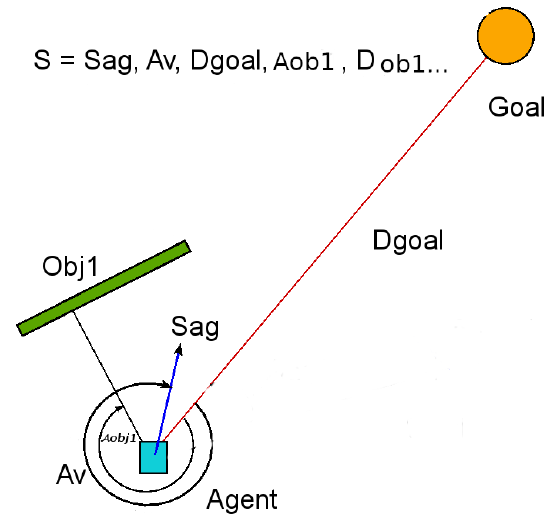
Figure 1. State space